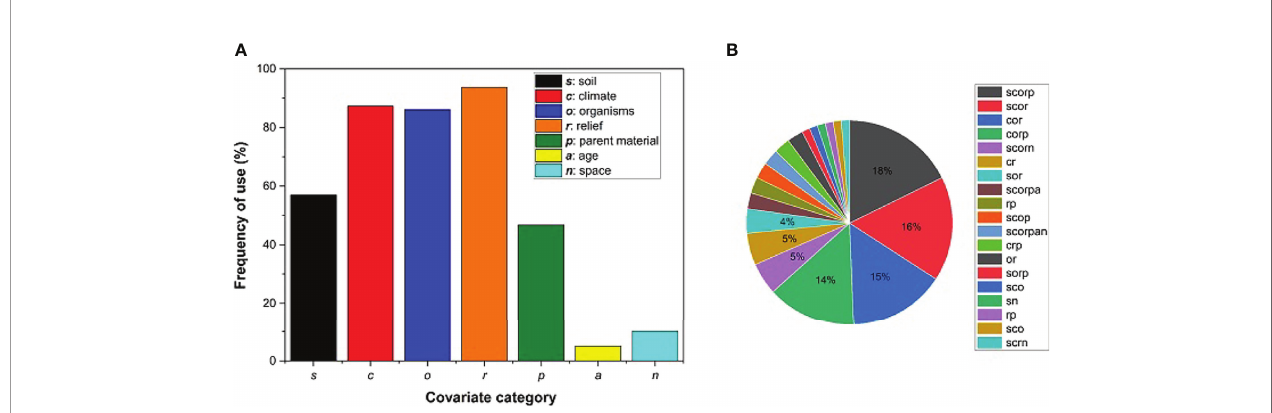
FIGURE 3 | The frequency of SCORPAN (A) covariate categories and the (B) combination of covariate categories used by regional and national scale studies to estimate soil organic carbon contents or stocks within agricultural